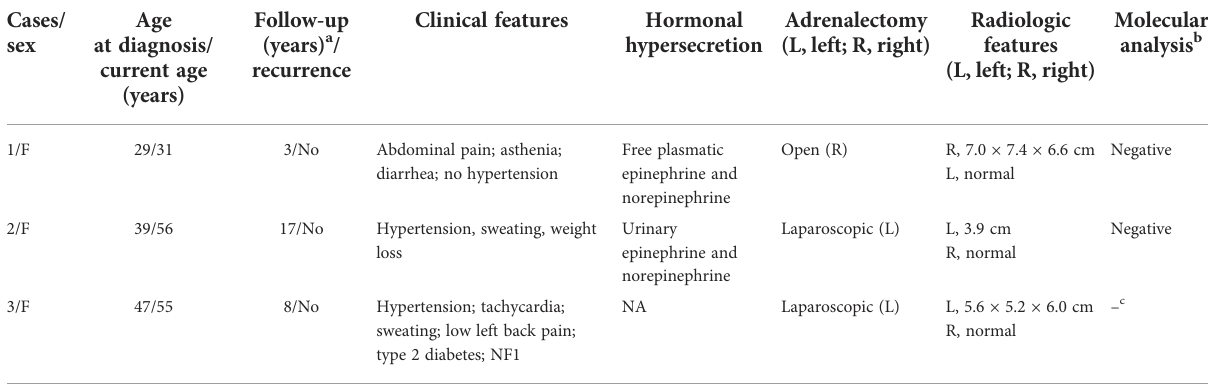
TABLE 1 Genetic, radiological, hormonal, and clinical pro fi les and outcomes of three women with composite PCC. Cases/